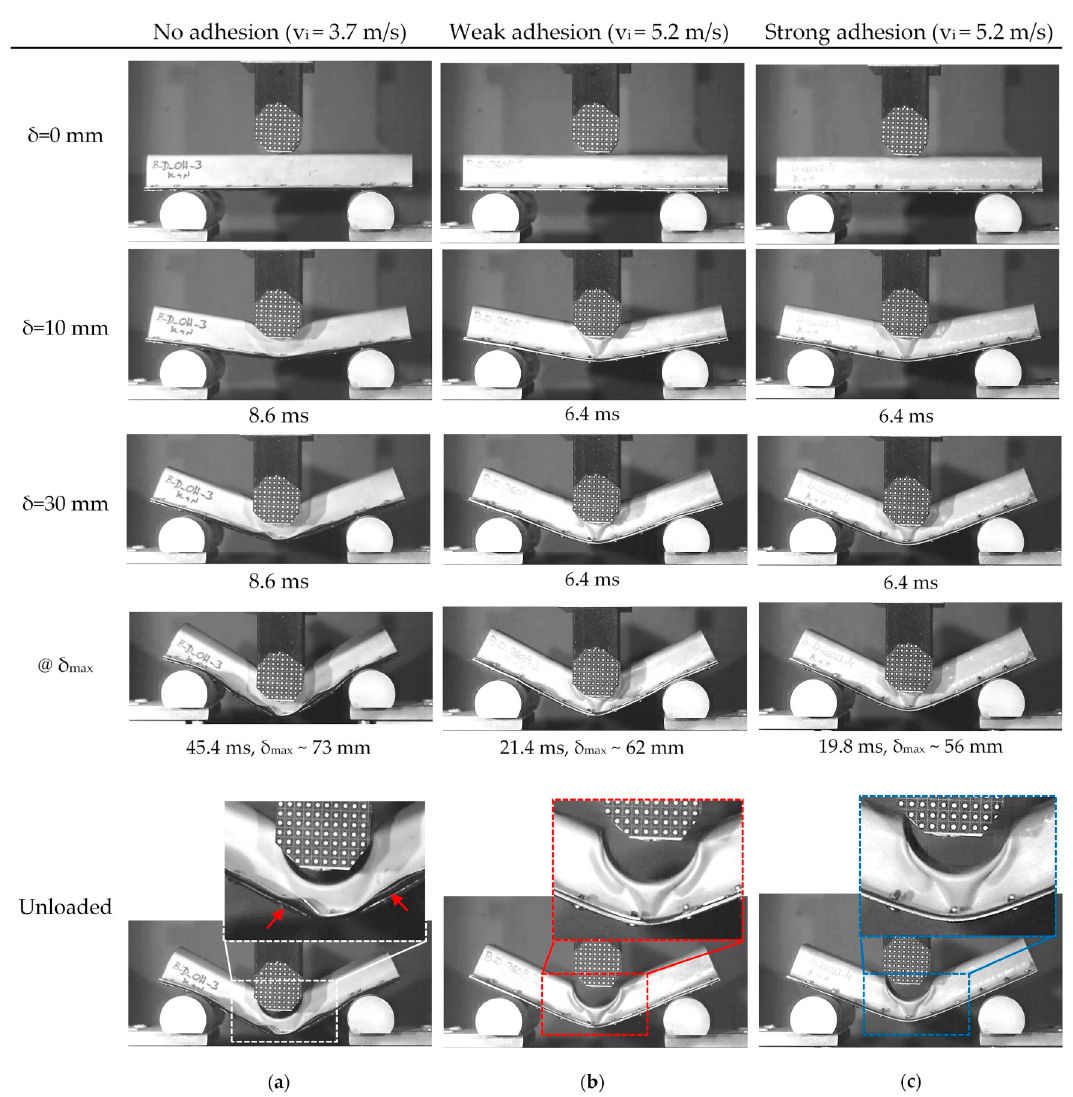
Figure A4. Photographic presentation of dynamic bending behavior at different time steps for the top-hat crashboxes ( a ) without, ( b ) with weak, and ( c ) with strong adhesion strength.